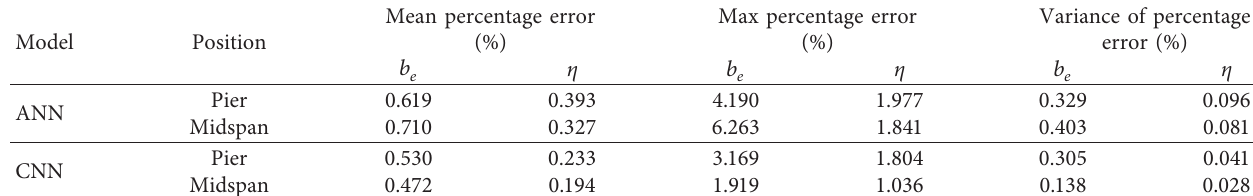
Table 3: Statistical parameters of 2 models.